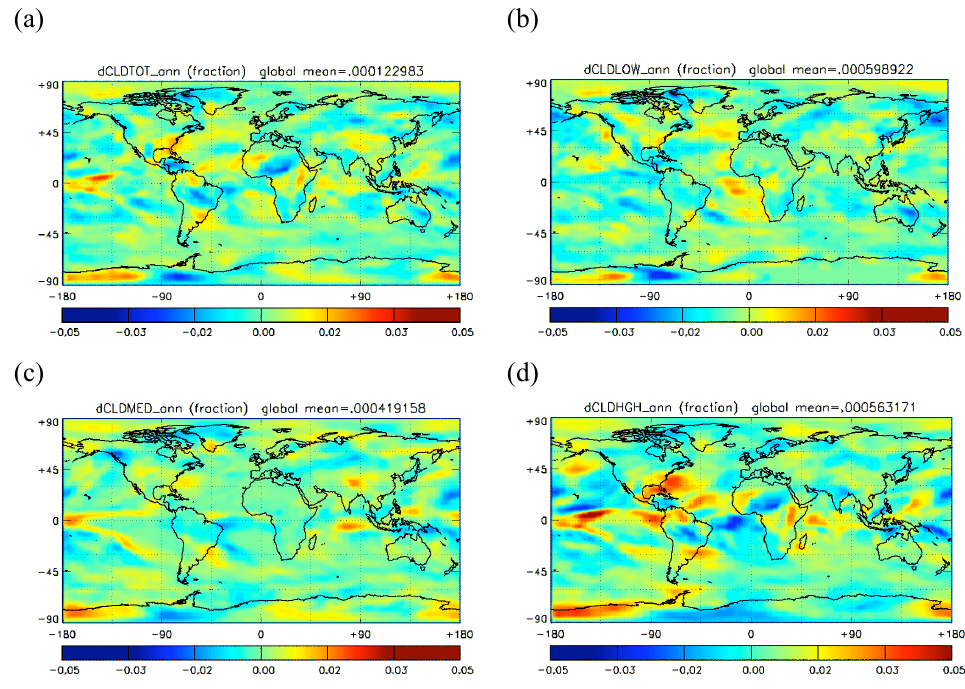
Fig. 8. Global distribution of annual mean of differences in cloud distributions due to seasonal BBCA emissions in: (a) total cloud fraction